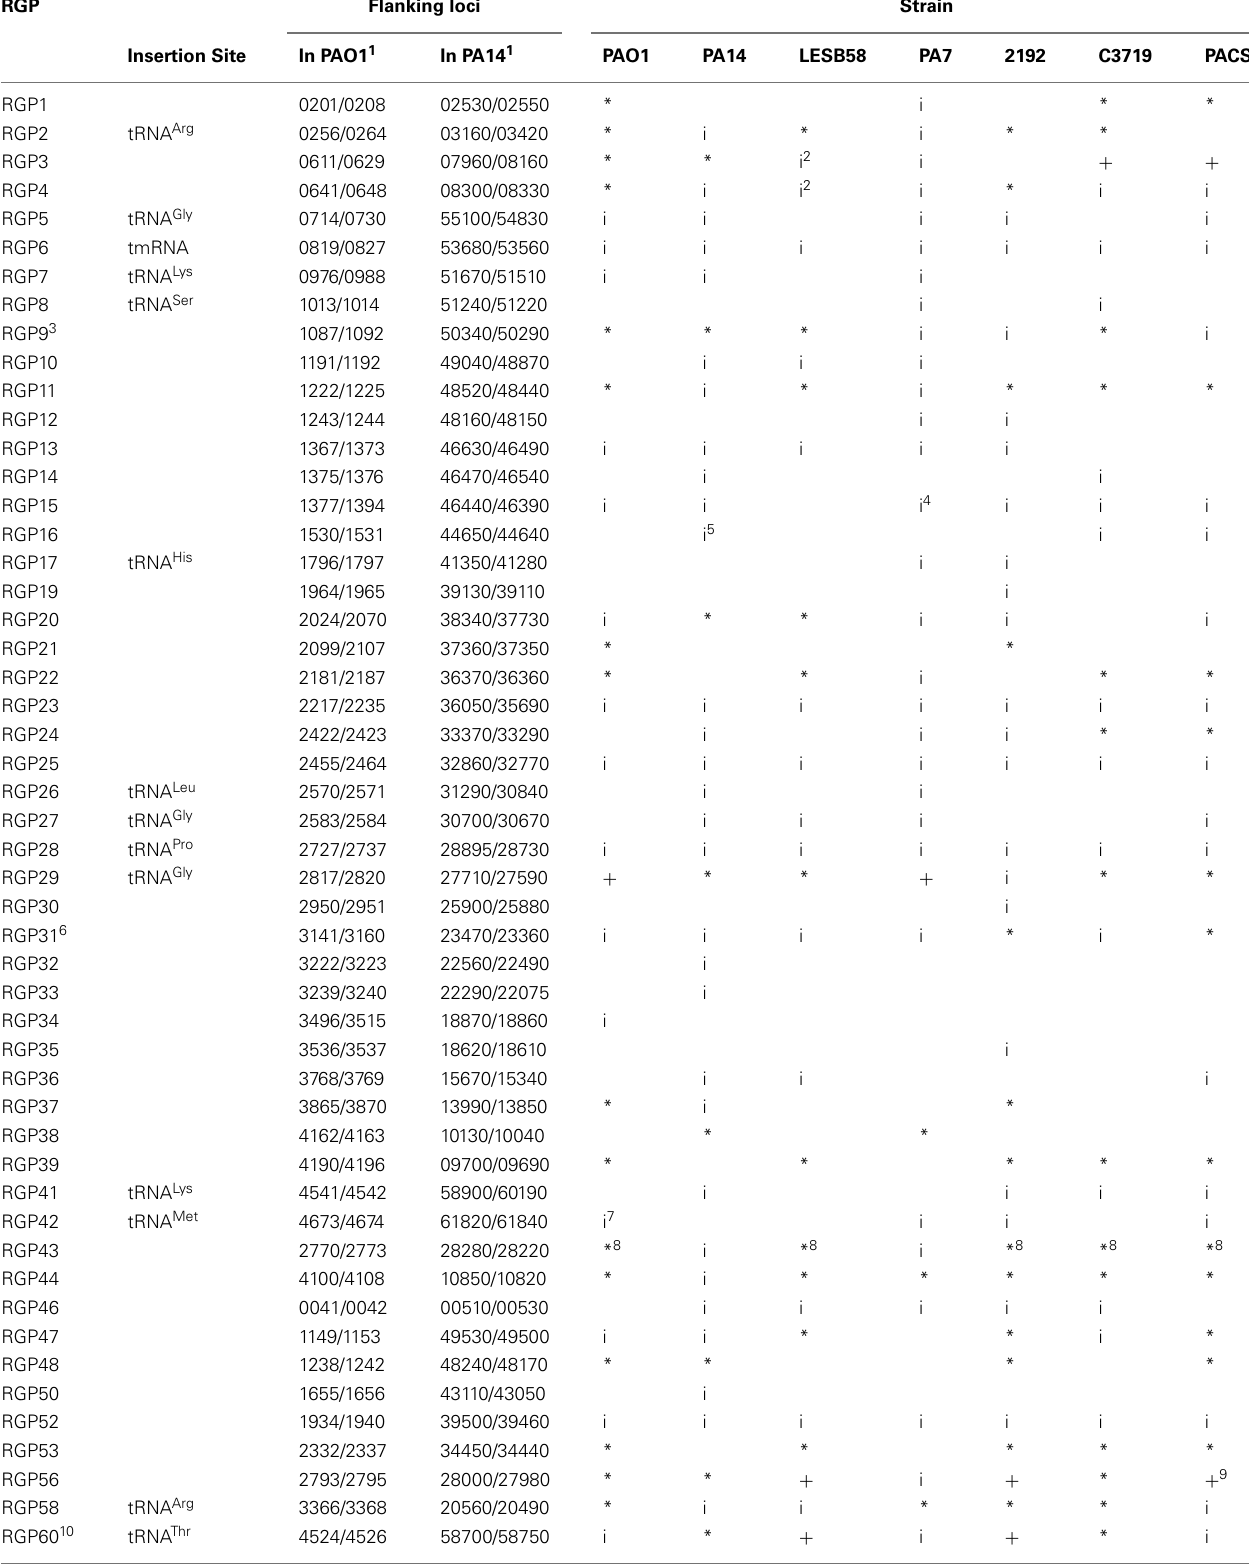
Table 2 | Regions of genome plasticity (RGP) in seven sequenced P. aeruginosa genomes. RGP Flanking